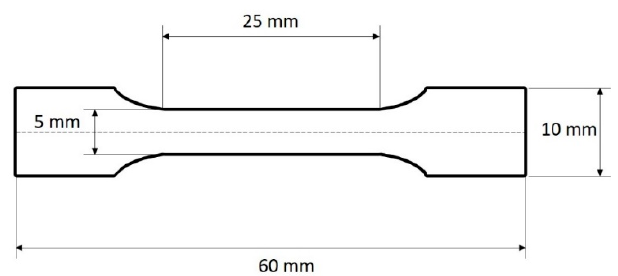
Figure 2. Schematic diagram of dog-bone shaped sample used for single fibre fragmentation tests.